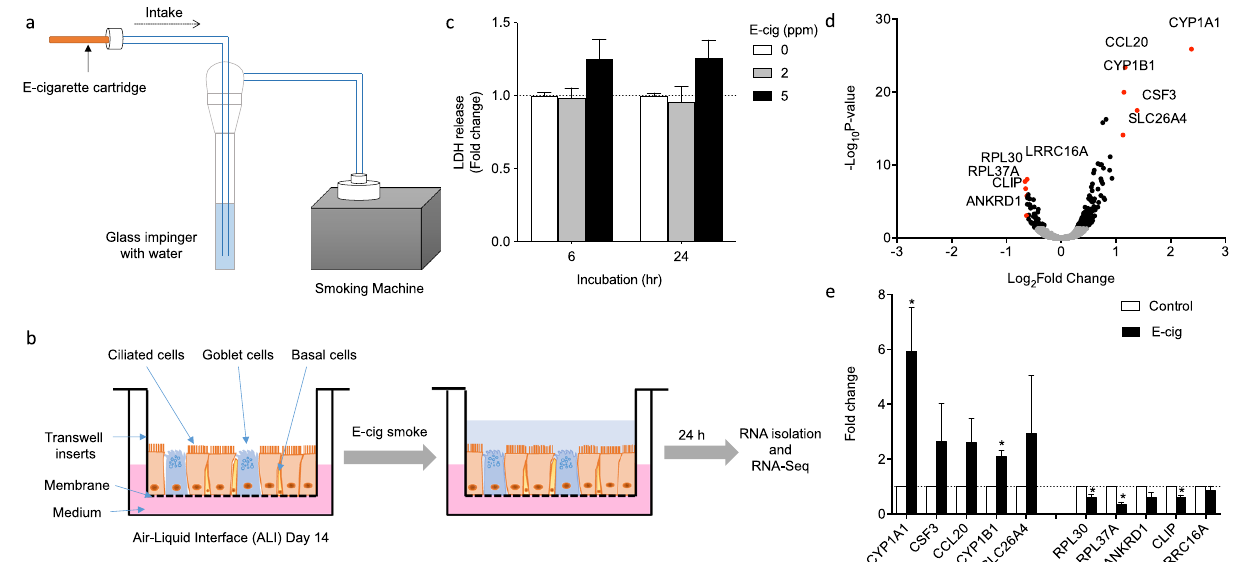
Figure 1. Identification of differential gene expression in NHBEs exposed to e-cigarette smoke solution by RNA-seq. ( A ) Preparation of e-cig smoke solution. ( B ) Schematic workflow of the study. ( C ) Cytotoxicity of e-cig smoke solution in NHBE cells. ( D ) Volcano plot of RNA-seq results with top 10 genes annotated in NHBE cells exposed to e-cig smoke solution for 24 h. Block dots represent gene with Padj < 0.05. Grey dots represent genes that do not meet the significance threshold. ( E ) qPCR validation of top 10 genes identified by RNA-seq with e-cig smoke solution. *, P < 0.05 compared to control. N = 3